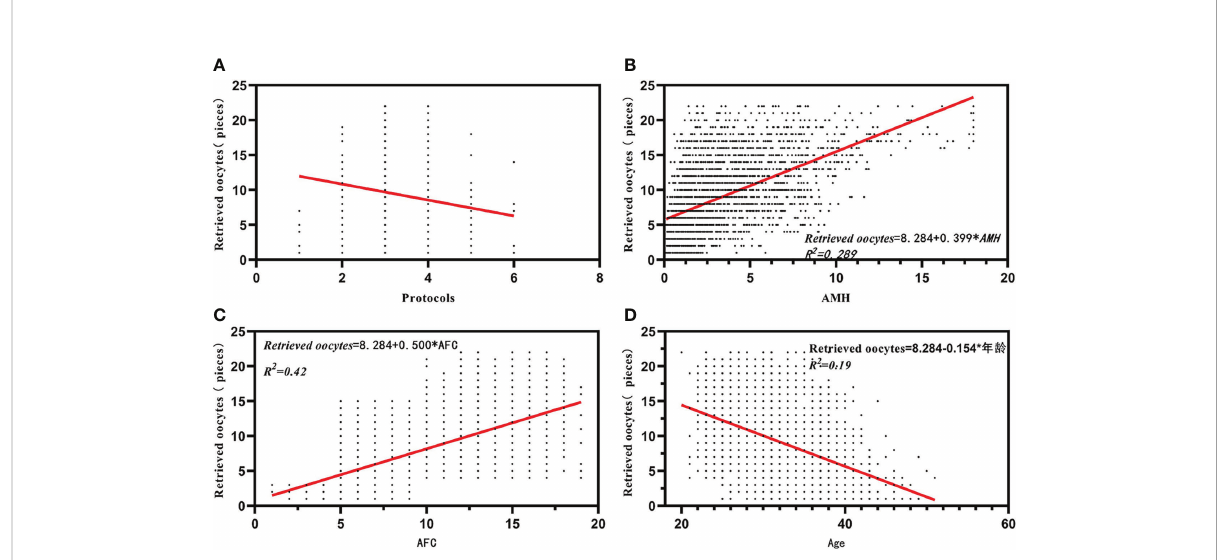
FIGURE 1 Correlation analysis between retrieved oocytes and affecting factors. (A) The correlation between retrieved oocytes and protocals. (B) The correlation between retrieved oocytes and AMH. (C) The correlation between retrieved oocytes and AFC. (D) The correlation between retrieved oocytes and Age.